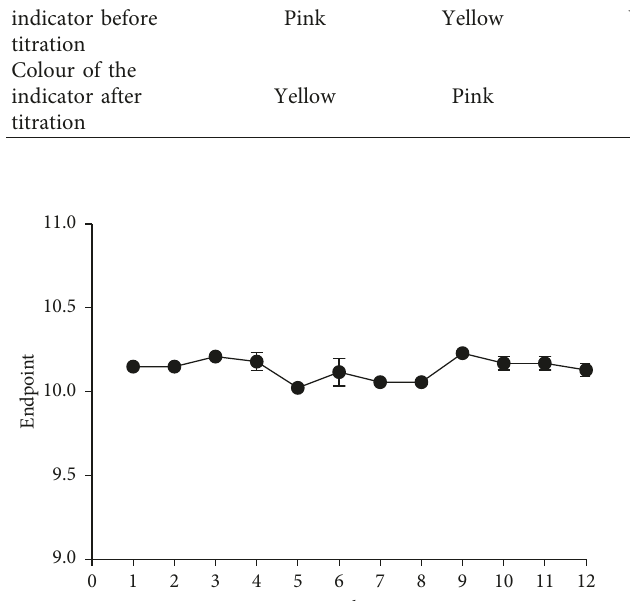
Figure 4: Endpoints obtained from a three-month study of use